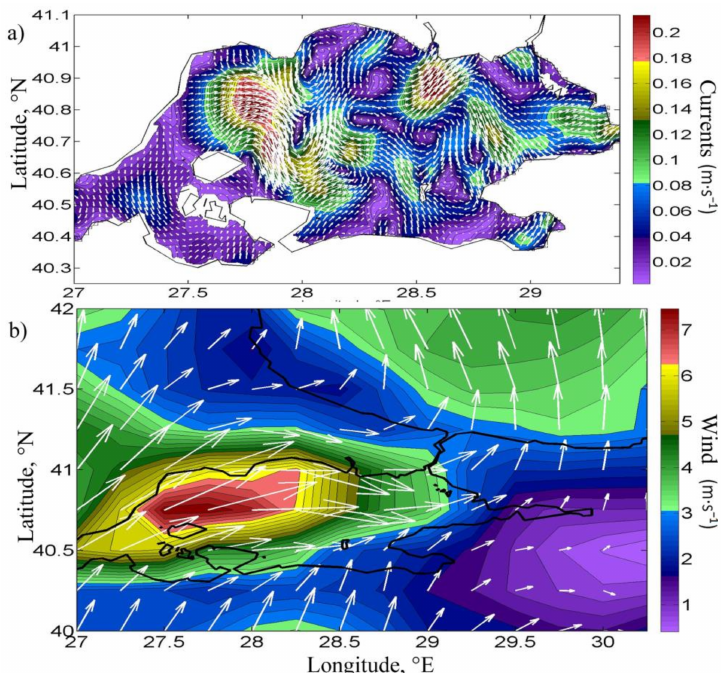
Figure 8. ( a ) Current magnitude (m · s − 1 ) computed from 4D-Var assimilation of Modis imagery; ( b ) wind velocity over the Marmara Sea on 25 May 2015 18:00